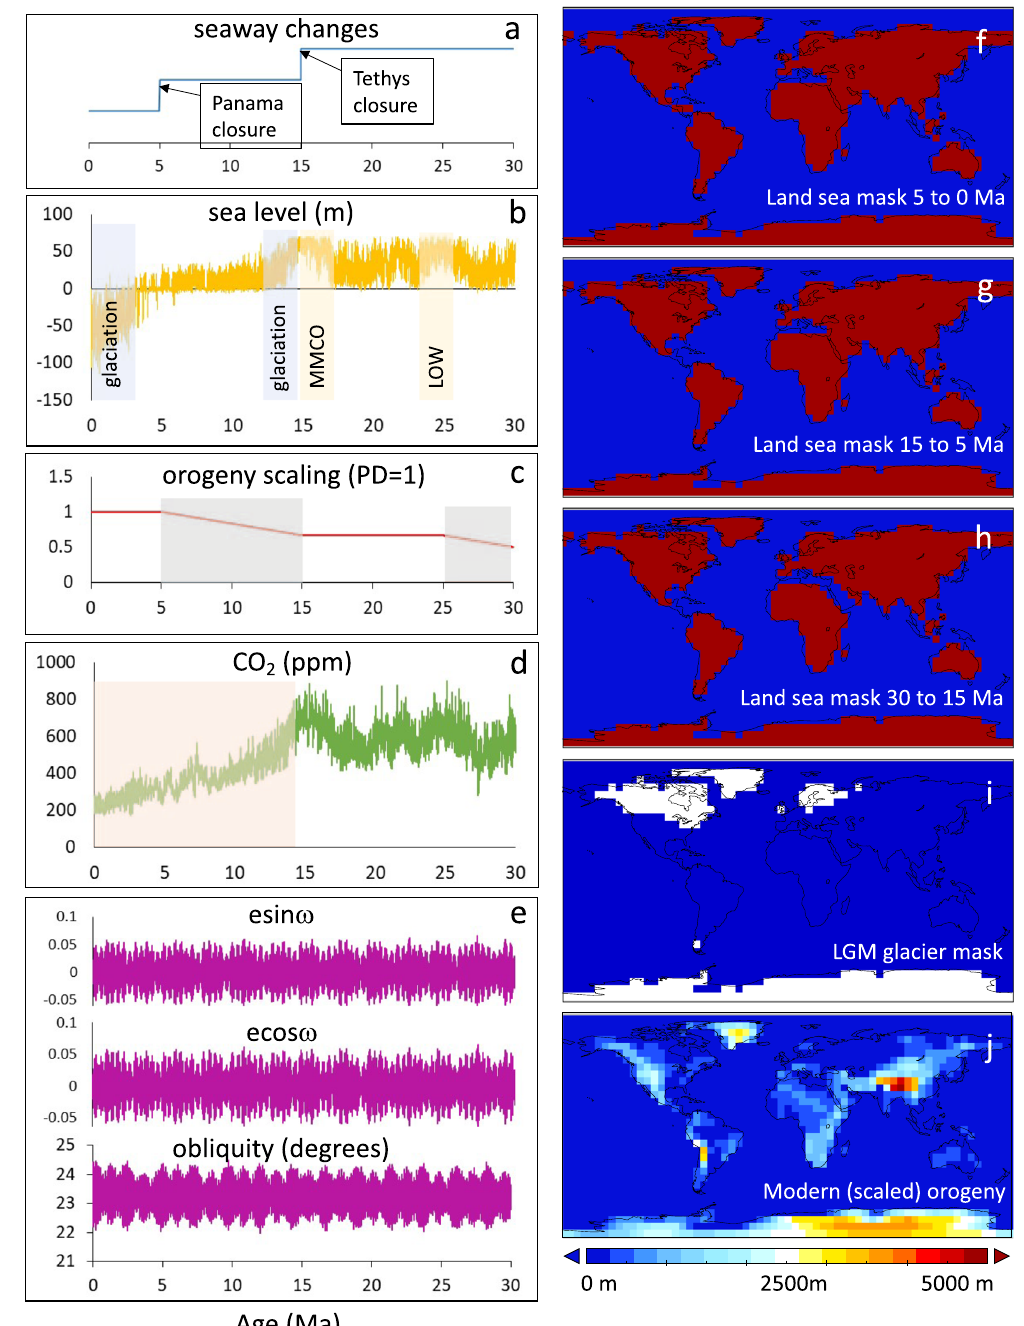
Fig. 2 Boundary conditions used in this study. Left panels are the time-series forcing, also used to derive priors for the total effect calulations (Supplementary Table 1), showing the assumed timing of ( a ) seaway land-sea mask changes, ( b ) sea-level 48 (MMCO Mid-Miocene Climate Optimum, LOW Late Oligocene Warming), ( c ) orogeny scaling (PD present day), ( d ) atmospheric CO 2 47,48 and ( e ) orbital forcing 56 (e eccentricity, ω longitude of the perihelion at the vernal equinox). Right-hand panels show the ( f ) 5 Ma to present, ( g ) 15 – 5 Ma, and ( h ) 30 – 15 Ma land-sea masks used in the study, ( i ) the Last Glacial Maximum (LGM) ice sheets 74 and ( j ) the modern